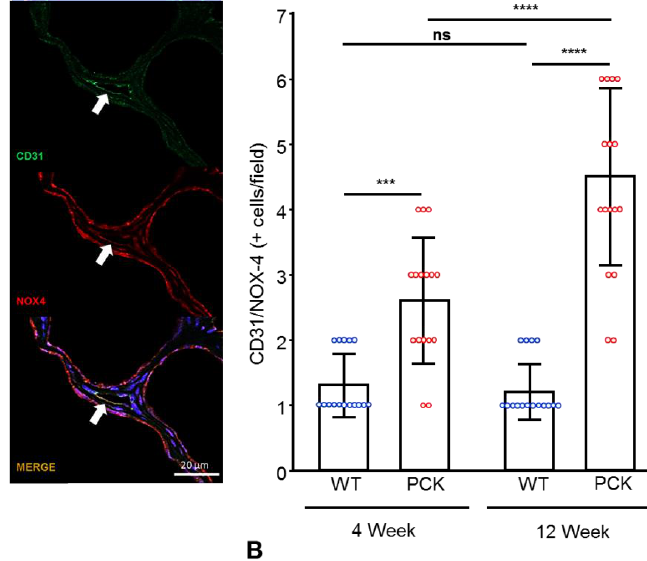
Figure 5. Renal NOX4 is upregulated in peritubular capillary endothelial cells in PKD. Representative IF staining for NOX4 (red) and endothelial cell marker CD31 (green) in renal tissue sections (40×) ( A ) and its quantification ( B ), showing increased number of double-positive cells (NOX4/CD31+) in PCK vs. WT rats at 4 weeks, which further increased at 12 weeks. *** p < 0.001; **** p < 0.0001. The number of double-positive NOX4/CD31cells was adjusted to the number of positive CD31 cells. (n = 16/group)